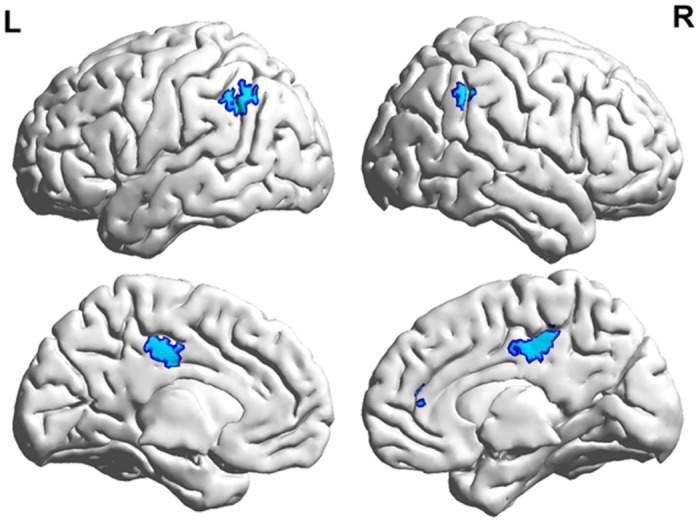
Conjunction results for the effects of transposable nonwords and lexicality (p < 0.001 uncorrected, k = 10).